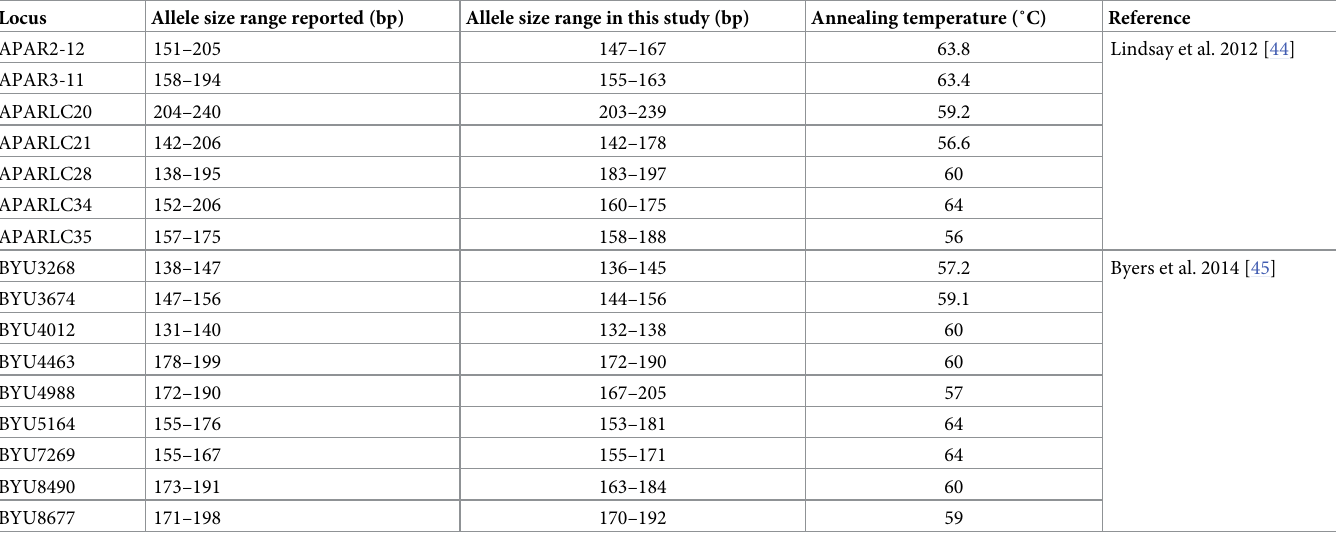
The size ranges, reported base pairs, are provided both from previous reports (see Reference column) and those recovered in this study. The annealing temperature for each locus is